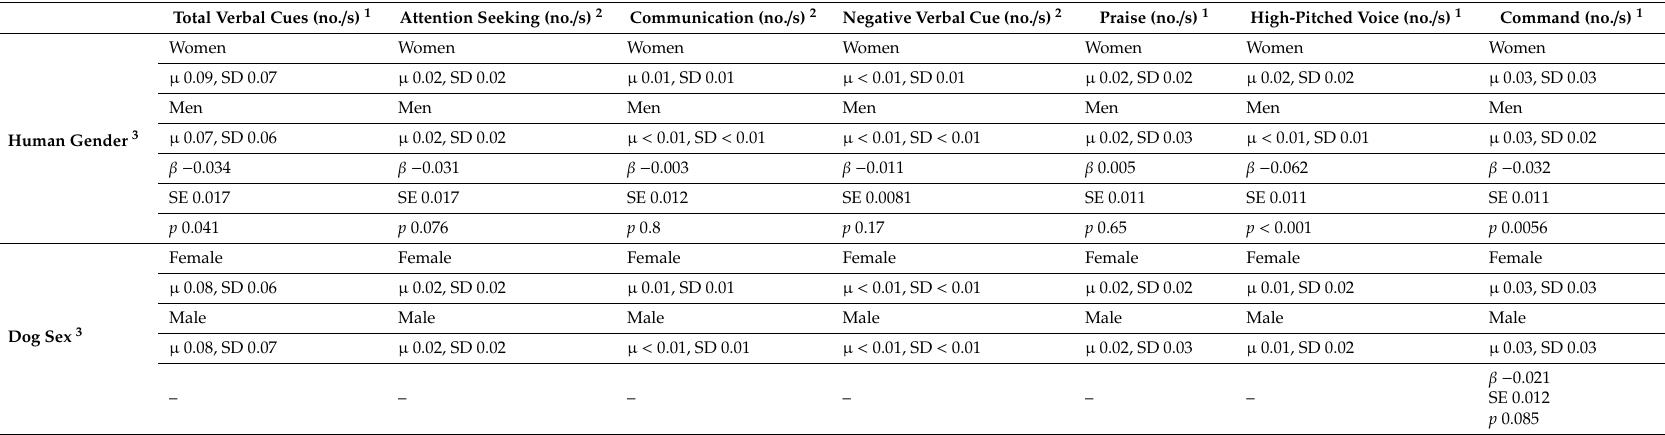
Table 8. Generalized linear mixed model of dog sex and human gender (independent variables) e ff ects on human verbal cues (dependent variables). Mean ( µ ) and standard deviation (SD) of di ff erent dependent variables by gender / sex was provided. All verbal cues were analysed as frequencies (numbers of events / total walking